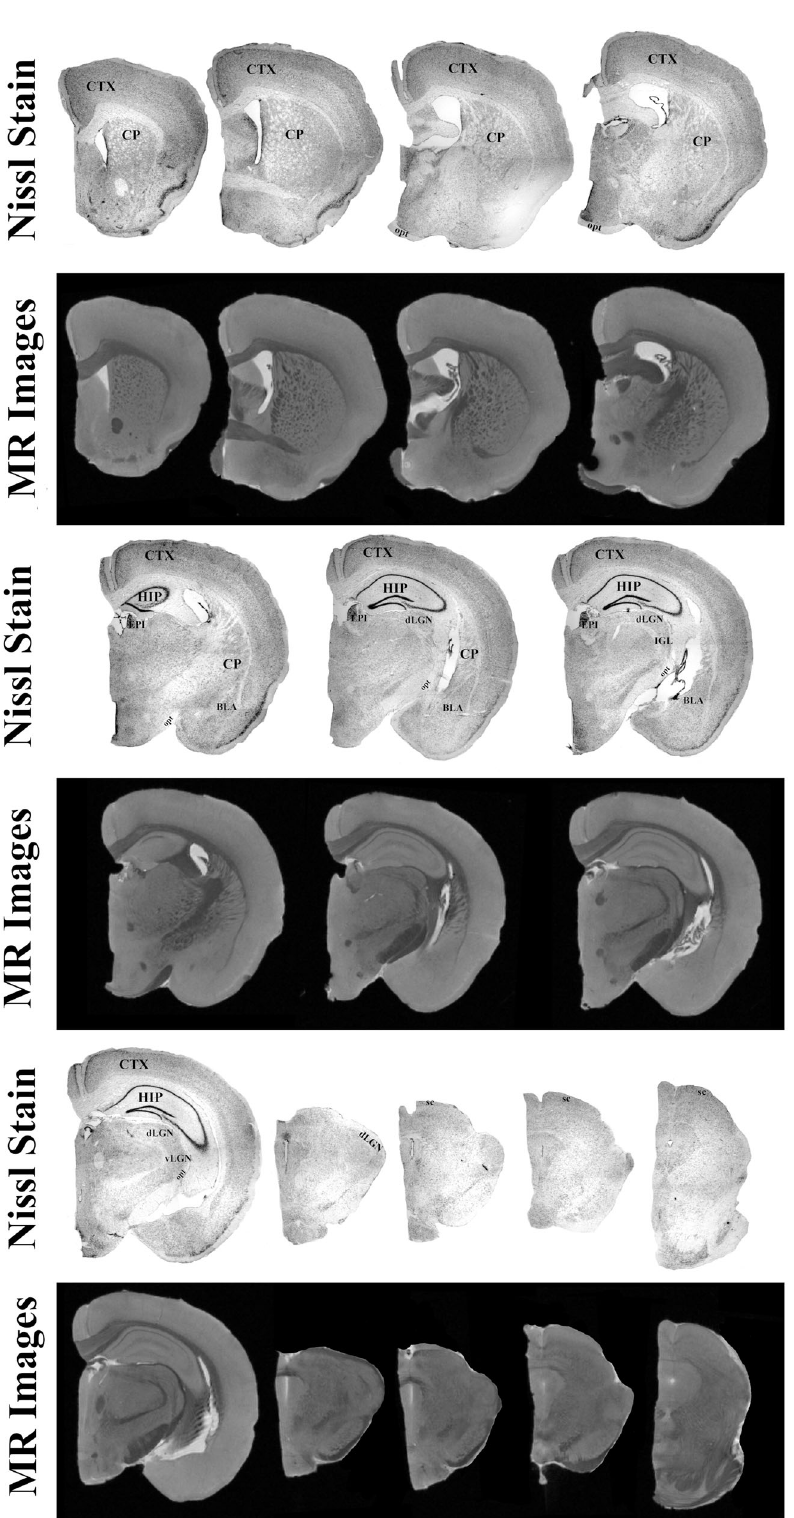
Fig. 6 High-resolution T1 weighted magnetic resonance images compared to Nissl stained brain sections from one representative mouse. Structures observed within the stained section are clearly identi fi ed within the scans. These structures include the cortex (CTX), caudate nucleus (CP), hippocampus (HIP), habenula (EPI), basolateral amygdala complex (BLA), optic tract (opt), superior colliculus (SC), and lateral geniculate nucleus (LGN). The greater resolution (32 µm) utilized in this manuscript allowed for the identi fi cation of subregion of the LGN, ventral (vLGN) and dorsal (dLGN)